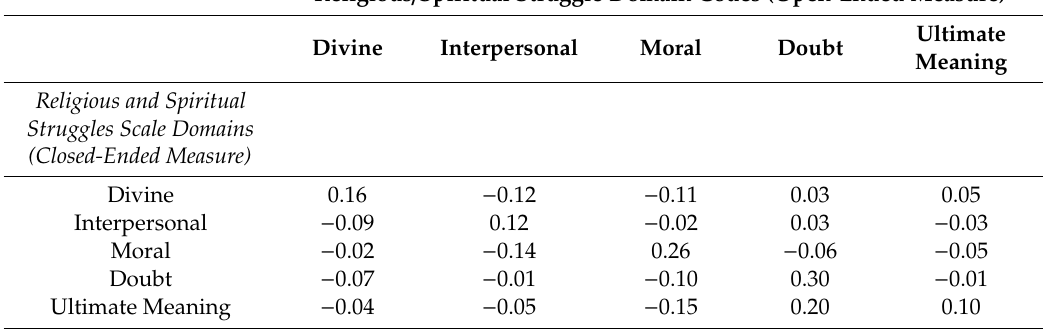
Table 4. Spearman Correlations between Religious and Spiritual Struggle Scale Domains and Religious / Spiritual Struggle Domain Codes.